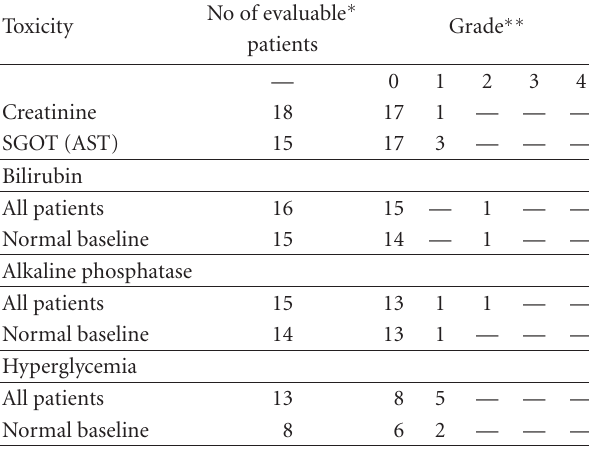
Table 5: Treatment-related biochemical toxicity (worst by pa- tient) (cid:0) .